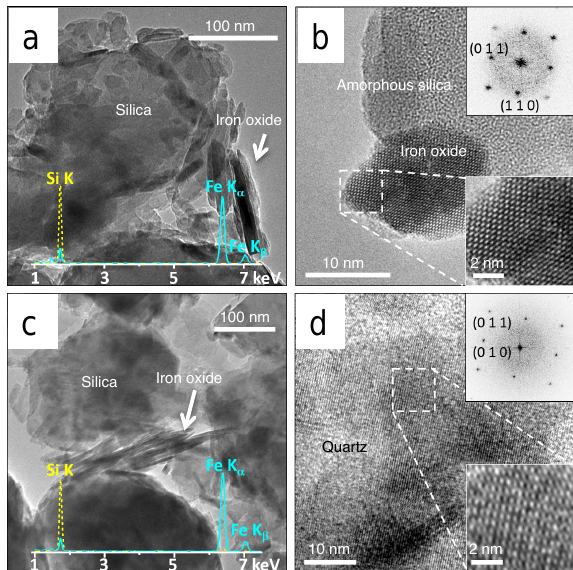
Figure 12. TEM characterization of an NFIF and MFIF speci- men. (a) Lower-magnification MFIF TEM-BF (bright field) mi- crograph. (b) High-resolution micrograph of NFIF showing amor- phous Si and Fe oxide crystalline lattice structures. Insets high- light a hematite particle viewed from the [1–11] axis (rhombohedral lattice). (c) Lower-magnification MFIF TEM-BF image. (d) High- resolution images of MFIF showing crystalline quartz and iron ox- ide crystalline lattice structures. Insets in (d) show a quartz crystal viewed from the [100] axis. Both samples contain silica with a few hundred nanometer particle size and smaller needle-like iron ox- ide particles. Spectral lines in panels (a) and (c) are X-ray energy dispersive elemental profiles of the individual Fe and Si mineral